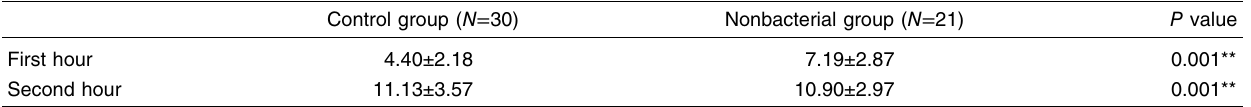
Table 14 Comparison between mean values of ESR (first and second hour) in the nonbacterial group relative to the control group Control group ( N = 30) First hour